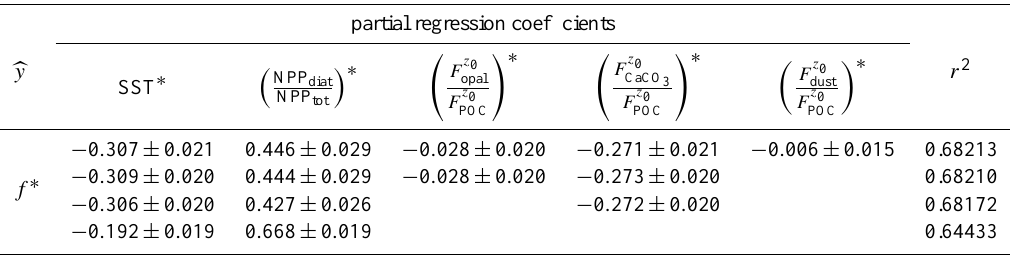
Table 2. Standard partial regression coefficients and coefficients of determination (r 2 ) for stepwise multivariate linear regression of stan- ) annual mean export ratio ( f ∗ ) on standardized annual mean SST, and ratios of vertically integrated NPP by diatoms dardized (x ∗ = x −¯ x σ x